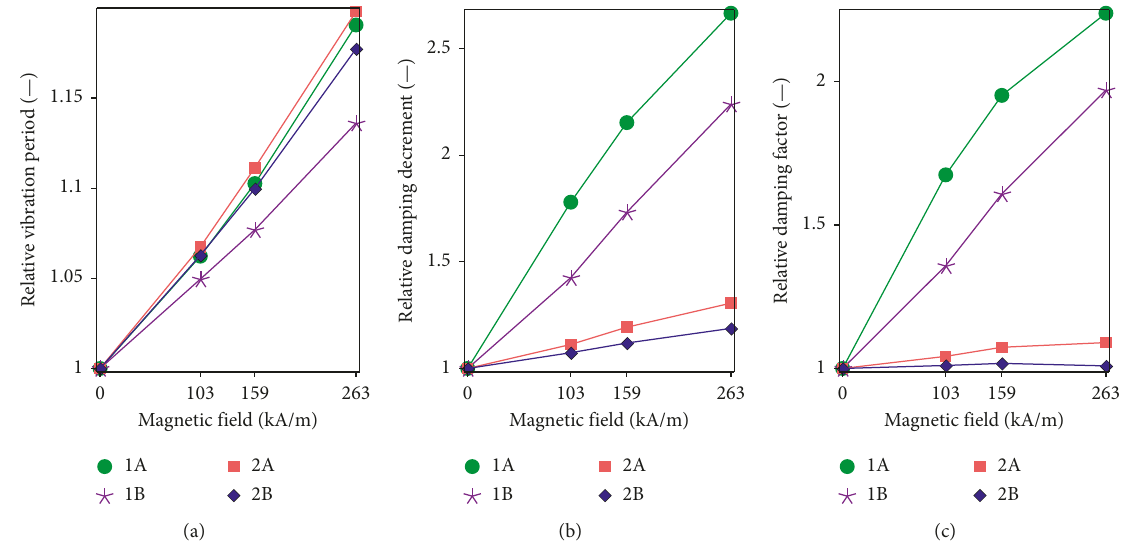
Figure 11: Relative increase of empirical vibration period (a), decrement (b), and damping ratio (c) for magnets M5 (103 kA/m), M8 (159kA/m), and M15 (263 kA/m).